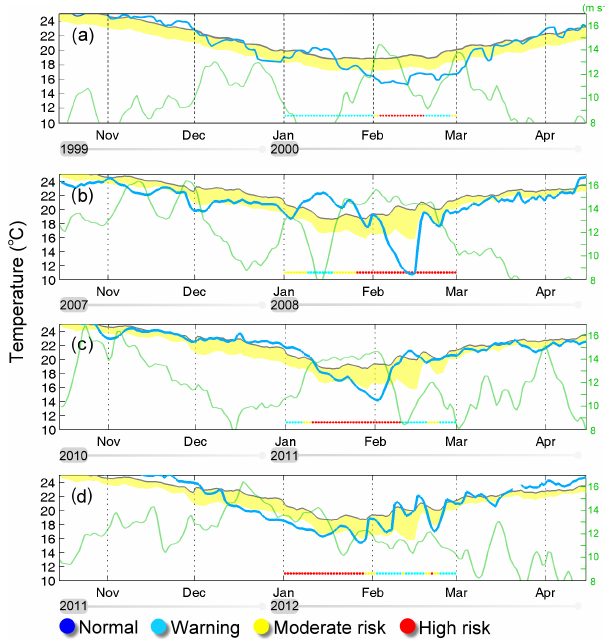
Figure 11. Cold events in (a) 2000, (b) 2008, (c) 2011, and (d) 2012. Blue line: SST observed (a) by satellite and (b, c, d) by buoy; gray line: 10-year climatological average; yellow shading: range of standard deviation below the average; green line: 10-day AWS. Color dots are warning